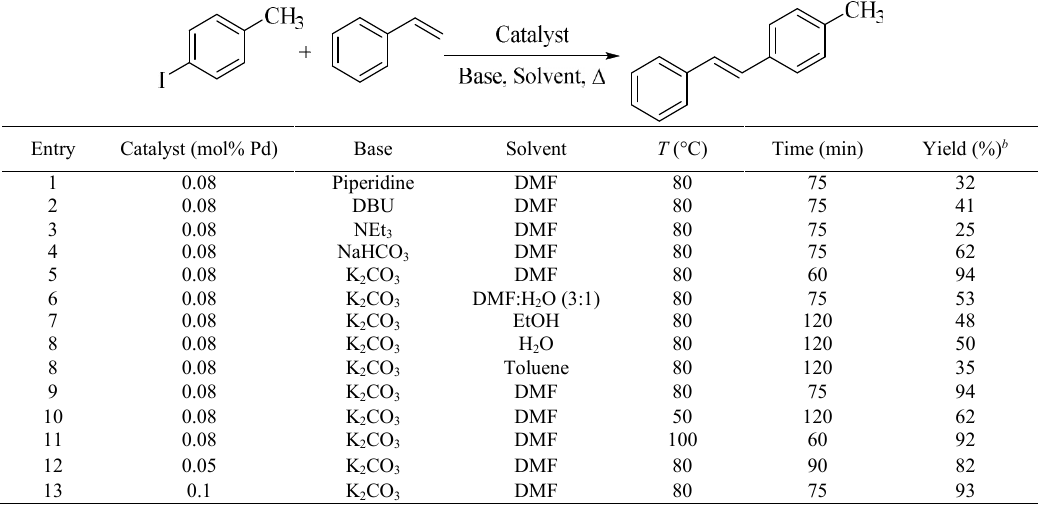
Table 3 Optimization of the conditions in the Heck reaction of 4–iodotoluene with styrene catalyzed by MNP/HPG-CA/Pd Table 3. Optimization of the conditions in the Heck reaction of 4-iodotoluene with styrene catalyzed by MNP/HPG-CA/Pd a